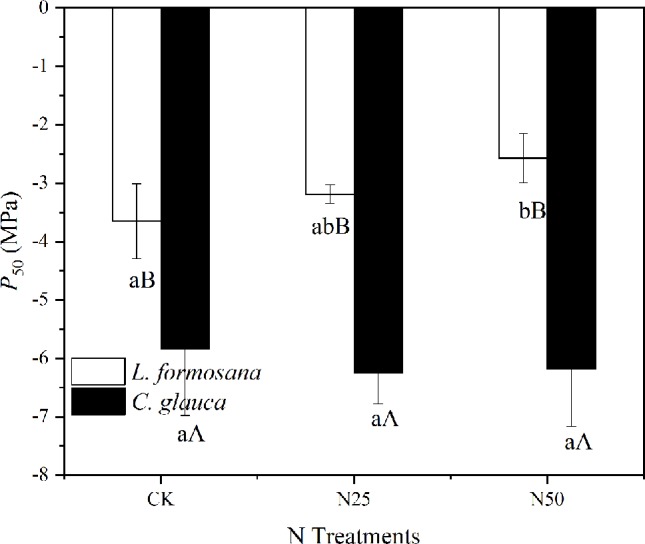
Changes in xylem vulnerability to cavitation P
50 across the three treatments for Liquidambar formosana and Cyclobalanopsis glauca. Differences between species within treatments and within treatments between species are indicated by different letters (p < 0.05).